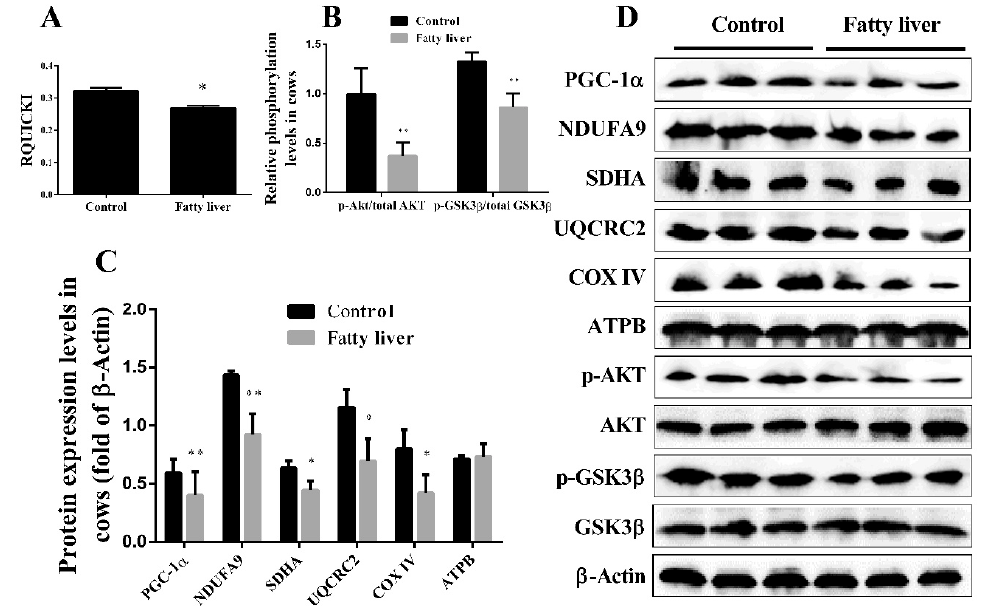
Figure 3. Dairy cows with fatty liver displayed impaired hepatic insulin signaling and mitochondrial respiratory chain function. ( A ) The value of revised quantitative insulin sensitivity check index (RQUICKI) in healthy and fatty liver cows; ( B – D ) Western blot analysis and quantification of key molecules of the insulin signaling pathway, PGC-1 α , and five representative subunits of oxidative phosphorylation (OXPHOS) complexes in the liver of healthy and fatty liver cows. β -Actin served as an internal control. Quantified data are mean ± SD; * p < 0.05 versus control group; ** p < 0.01 versus control group.